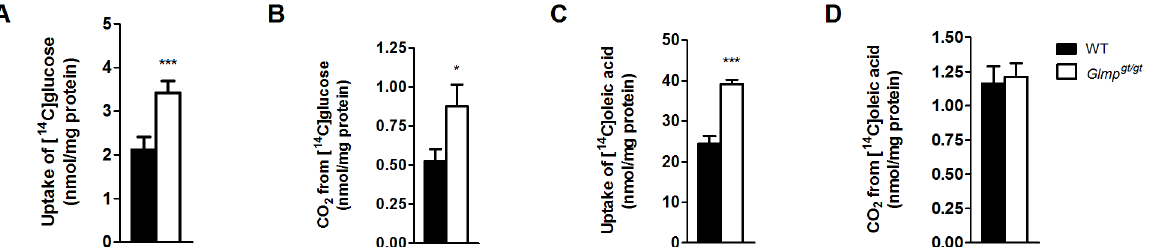
Fig 5. Glucose and oleic acid oxidation in WT and Glmp gt/gt hepatocytes. Overnight cultured primary hepatocytes from WT and Glmp gt/gt mice were incubated with [ 14 C]glucose (0.6 μ Ci/mL, 200 μ M) or [ 14 C]oleic acid (OA) (0.5 μ Ci/mL, 100 μ M) for 4 h. (A) Total [ 14 C]glucose uptake, (B) [ 14 C]glucose oxidation, (C) [ 14 C]OA uptake and (D) [ 14 C]OA oxidation were measured. Substrate uptake was calculated as the sum of cell-associated radioactivity and [ 14 C]CO 2 production. Substrate oxidation was measured as [ 14 C]CO 2 production. Results were normalized to protein content (n = 20 experiments, representing 4 individual mice/genotype, with 5 replicates each, * p < 0 . 05 , *** p < 0 . 005 vs. WT). Values are presented as mean ± SEM.